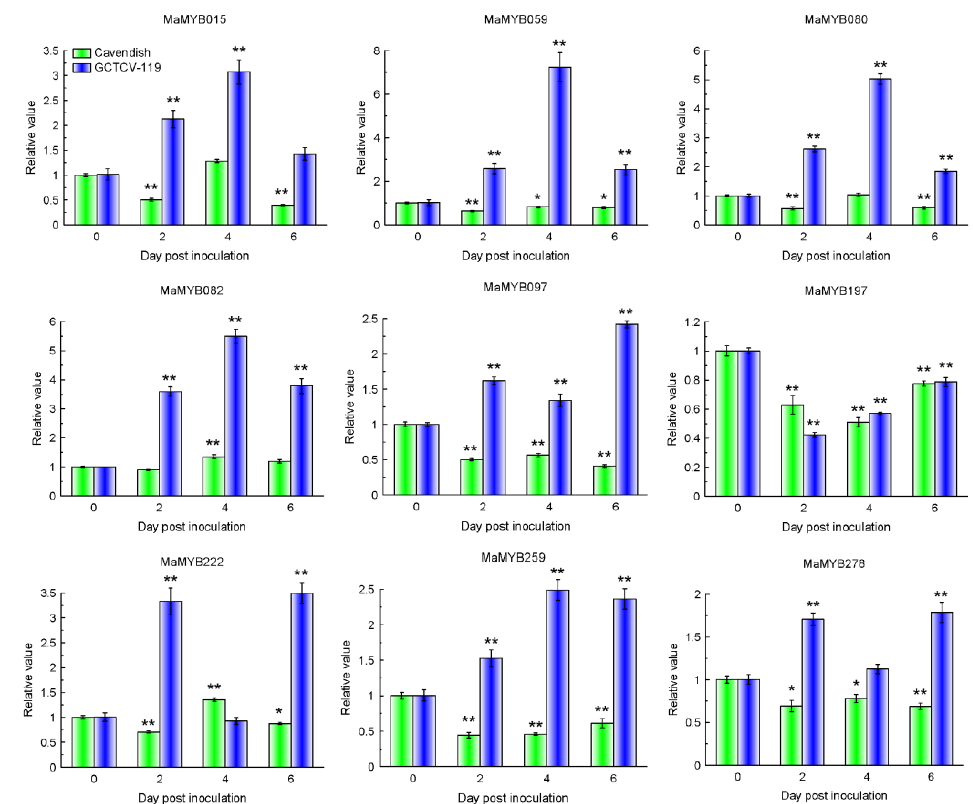
Figure 7. Expression patterns of nine MaMYBs in “Cavendish” and “GCTCV-119” banana seedlings inoculated with Foc TR4 identified using qRT-PCR. The results are presented as differential relative transcript abundance. The data represent the mean ± standard deviation (SD) of three replicates. The y -axis shows the transcript fold-change relative to that in the control (0 DPI). * and ** indicate significant differences from the control (0 DPI) at p < 0.05 and 0.01, respectively.